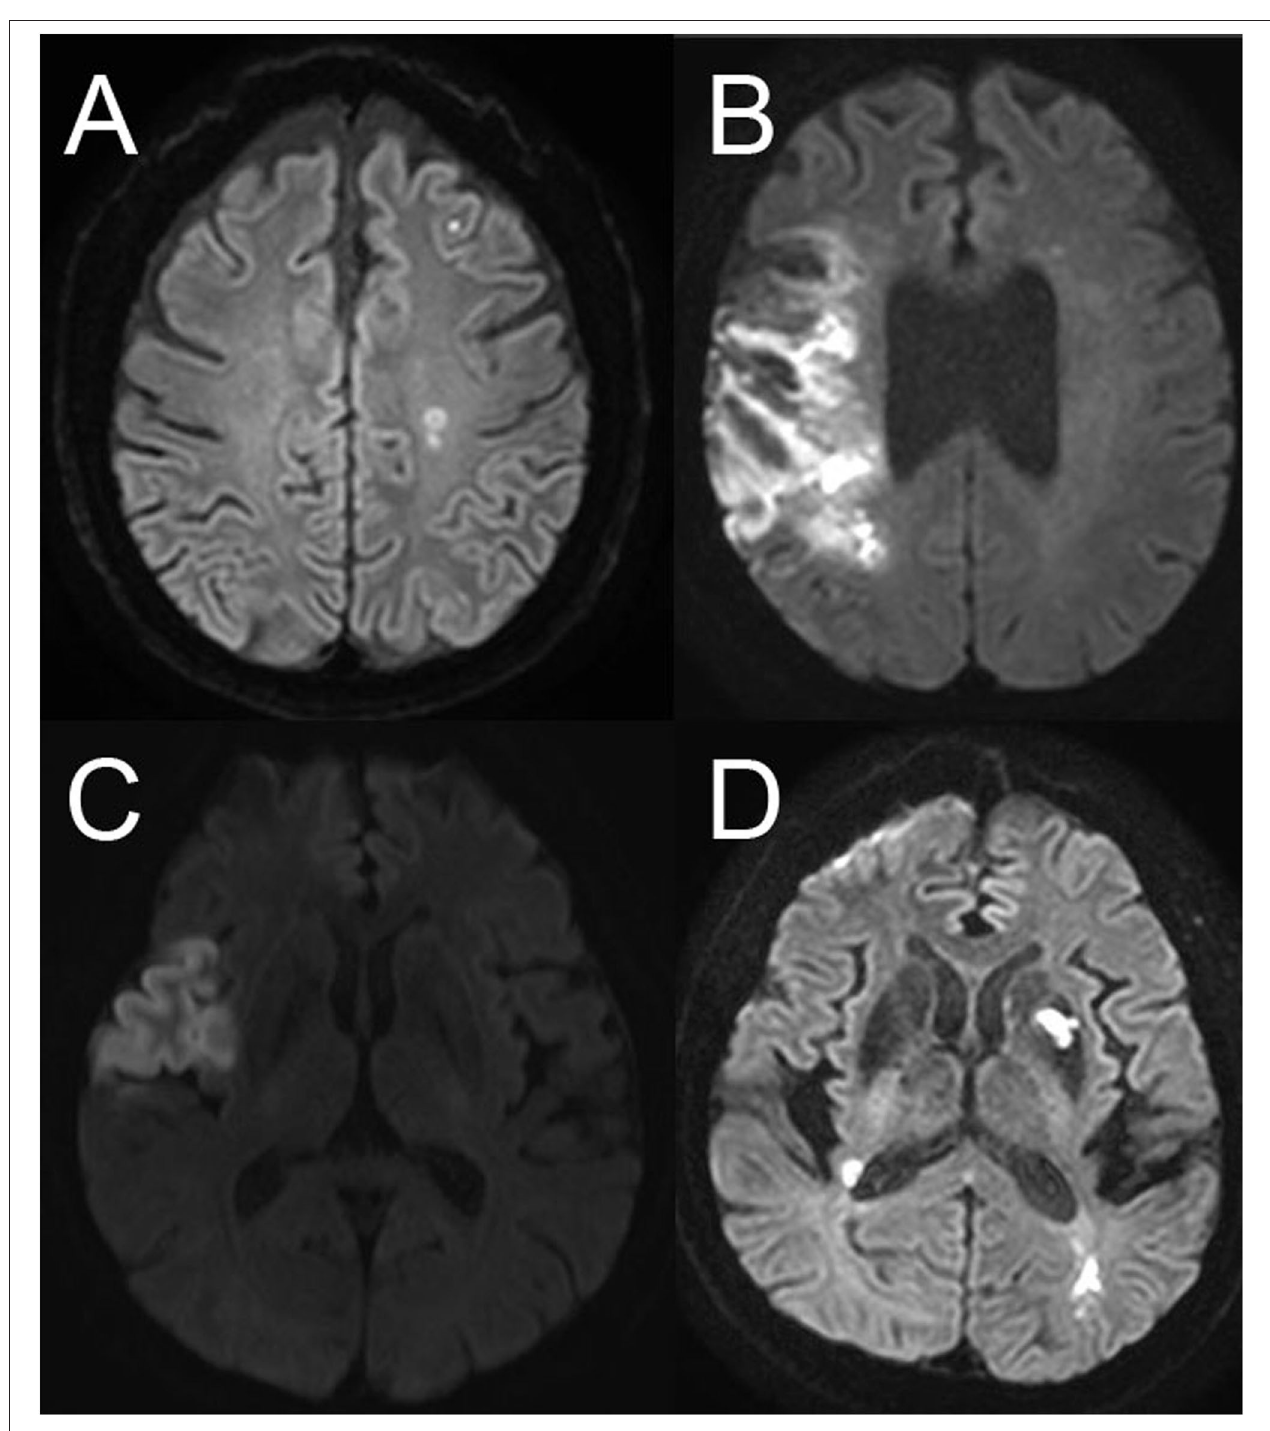
FIGURE 1 | Neuroimaging patterns of embolic stroke of undetermined source. (A) Scattered infarctions, (B) whole-territorial infarction, (C) lobar infarction, (D) multiple-territorial infarction.